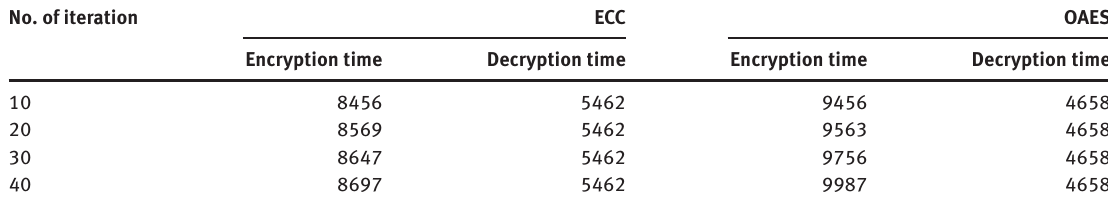
Table 1: Encryption and Decryption Time for Various Iteration. No. of